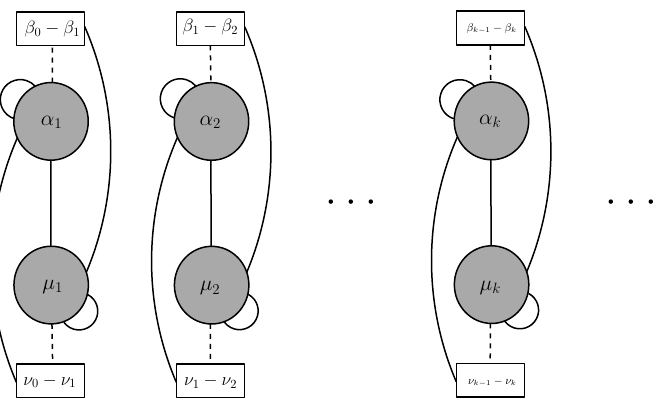
Figure 1 . A generic one dimensional quiver field theory whose IR limit is dual to the AdS 2 backgrounds given in